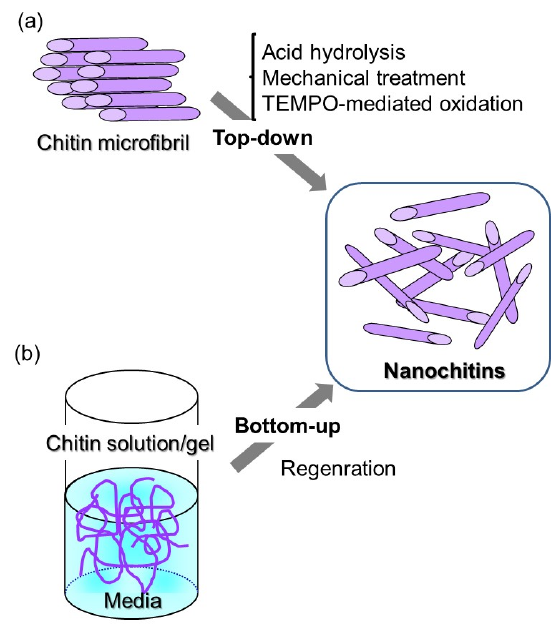
Figure 2. Fabrication of nanochitins upon: ( a ) top-down; and ( b ) bottom-up